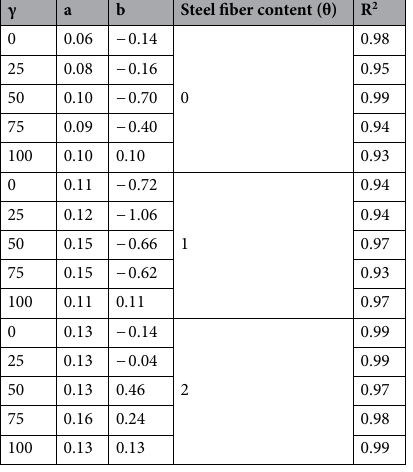
Table 3. Results of γ-value parameter analysis (mass loss rate fitting).